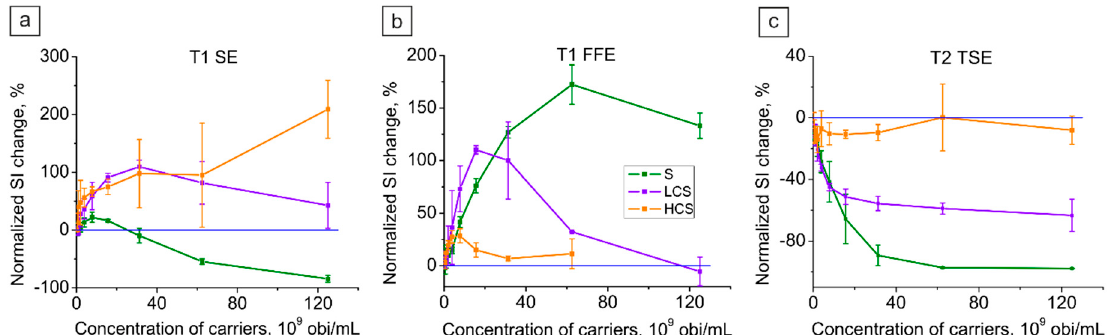
Figure 8. MRI contrast dependence on Fe concentration in submicron core–shells suspension for ( a ) T 1 spin-echo, ( b ) T 1 gradient-echo, and ( c ) T 2 turbo spin-echo: green curve—S sample; purple curve—LCS, and orange curve—HCS submicron core–shells. The blue line on each graph–water contrast level.